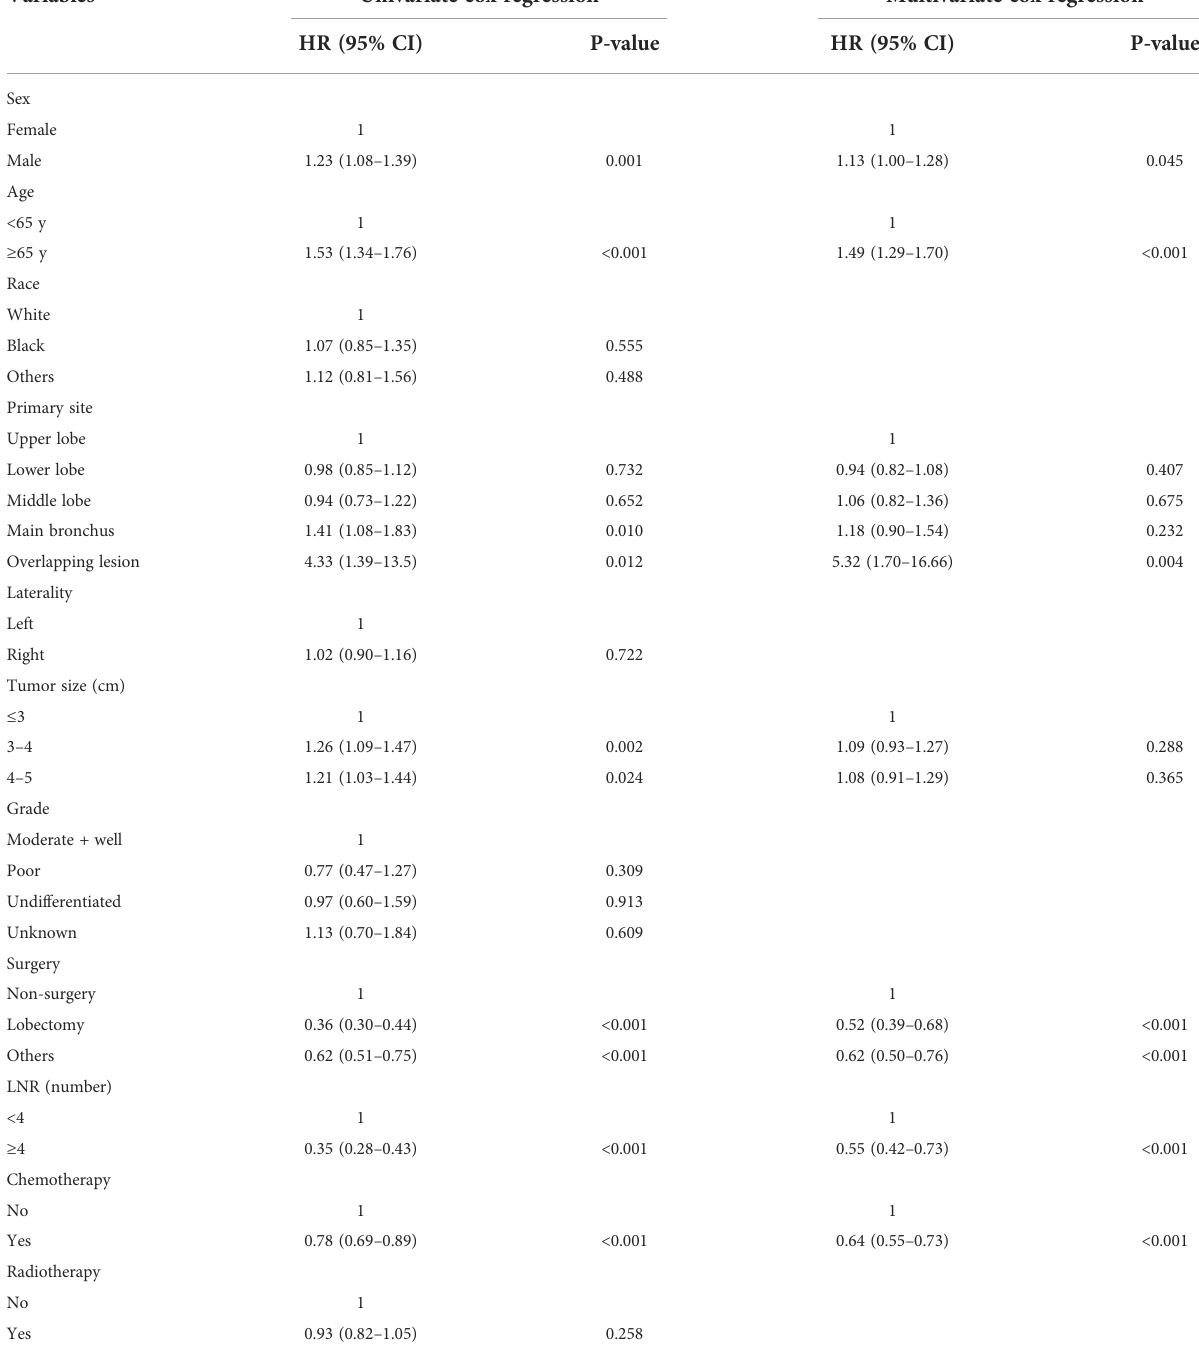
TABLE 2 Univariable and multivariate Cox proportional hazards regression analysis for overall